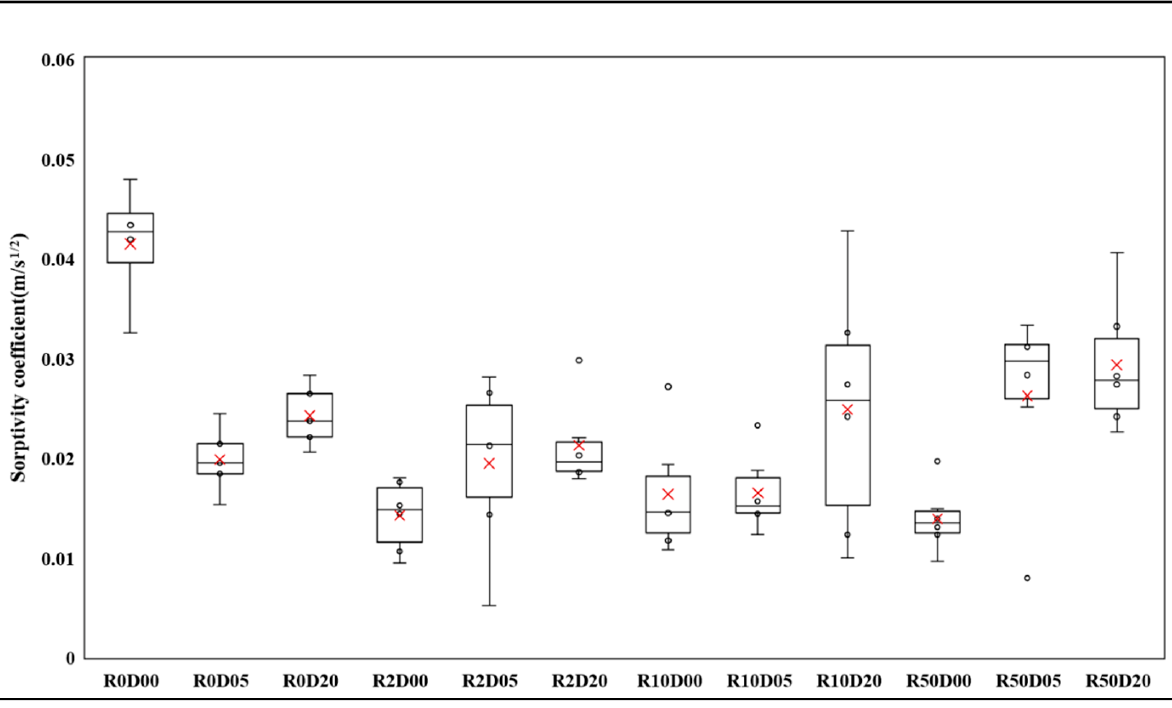
Figure 6. Variation of sorptivity with ash treatment and rainfall intensity.